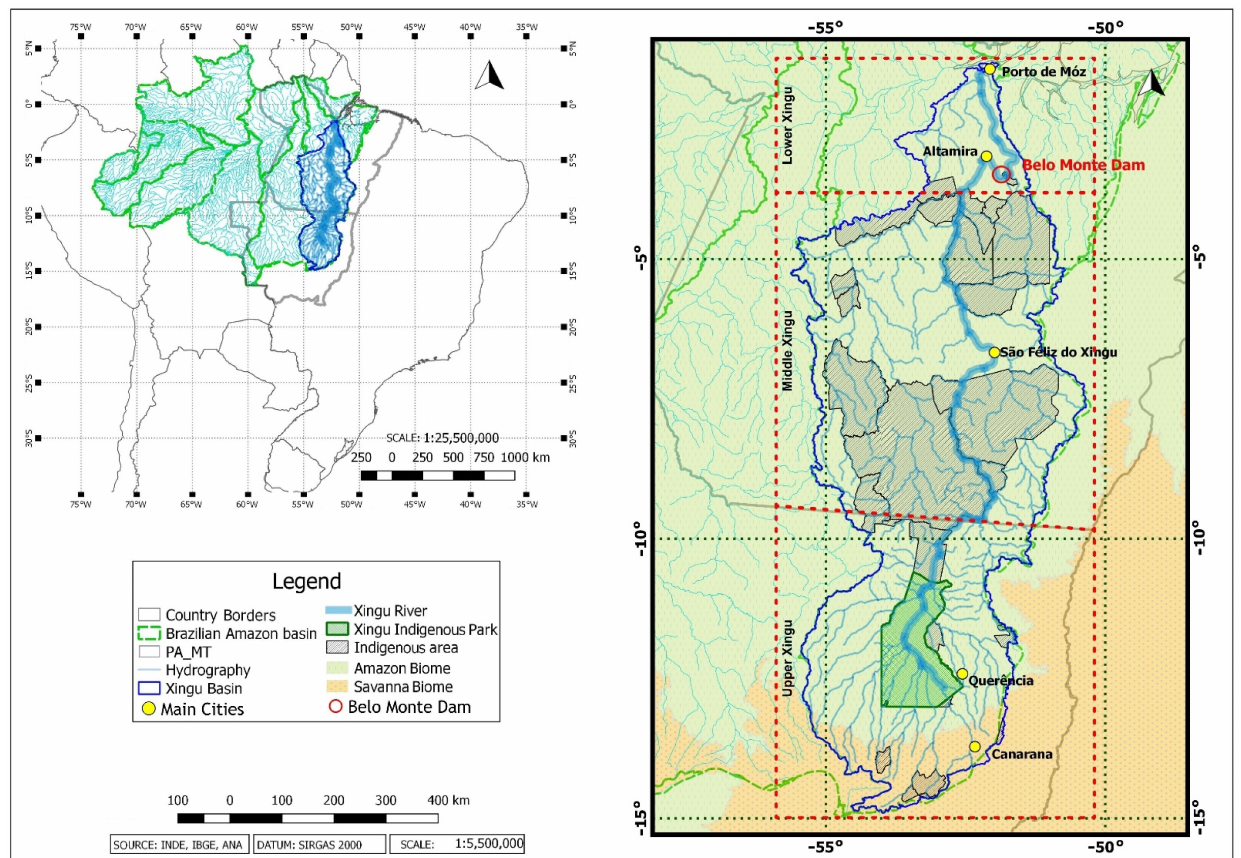
Figure 1. Geographical location of the XRB. Source: